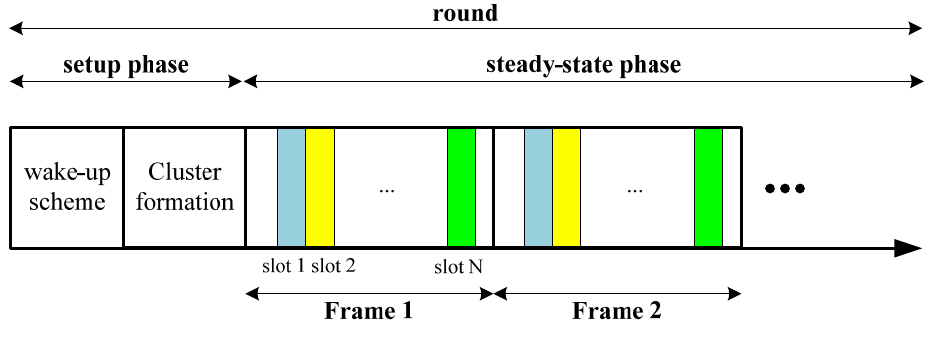
Figure 7. An illustration of time slot arrangement in one round in